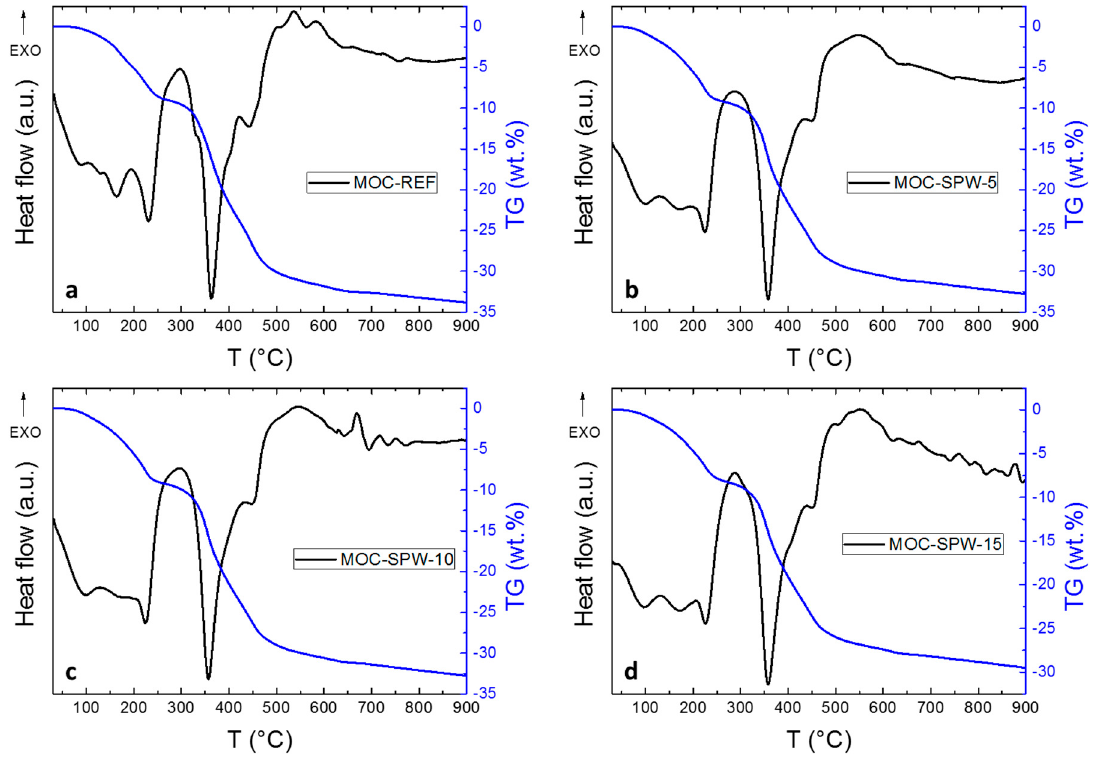
Figure 5. STA of ( a ) MOC-REF, ( b ) MOC-SPW5, ( c ) MOC-SPW10, and ( d ) MOC-SPW15.